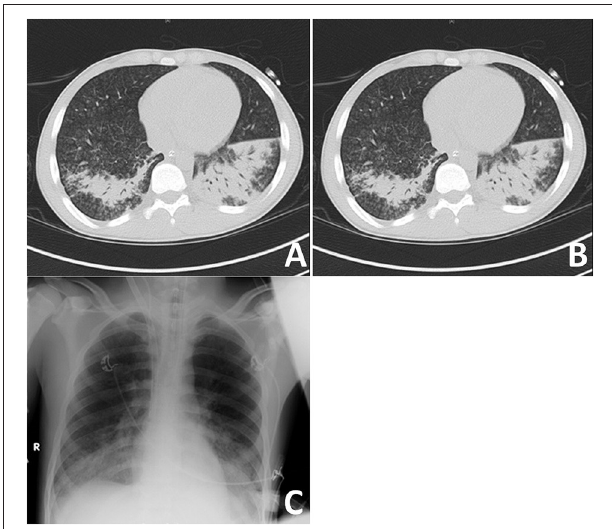
FIGURE 1 | Imaging of most severe autoimmune lung disease on admission. (A) Recruitment CT-scan for acute respiratory distress syndrome (ARDS) at FiO 2 of 100% in deep analgo-sedation, as well as muscle relaxation with cis-atracurium at a PEEP-level of 5 cmH 2 O and PIP at 15 cmH 2 O with tidal volumes at 6 ml/kg ideal body weight (IBW) in an expiratory hold after 3min at this level; (B) CT-scan after 1min of recruitment at a PEEP-level of 10cm H 2 0 and a PIP of 35cm H 2 O, followed by 1min at a PEEP-level of 20cm H 2 O and a PIP of 45cm H 2 O at an inspiratory hold; (C) Conventional imaging with bilateral inflammatory consolidations in lower